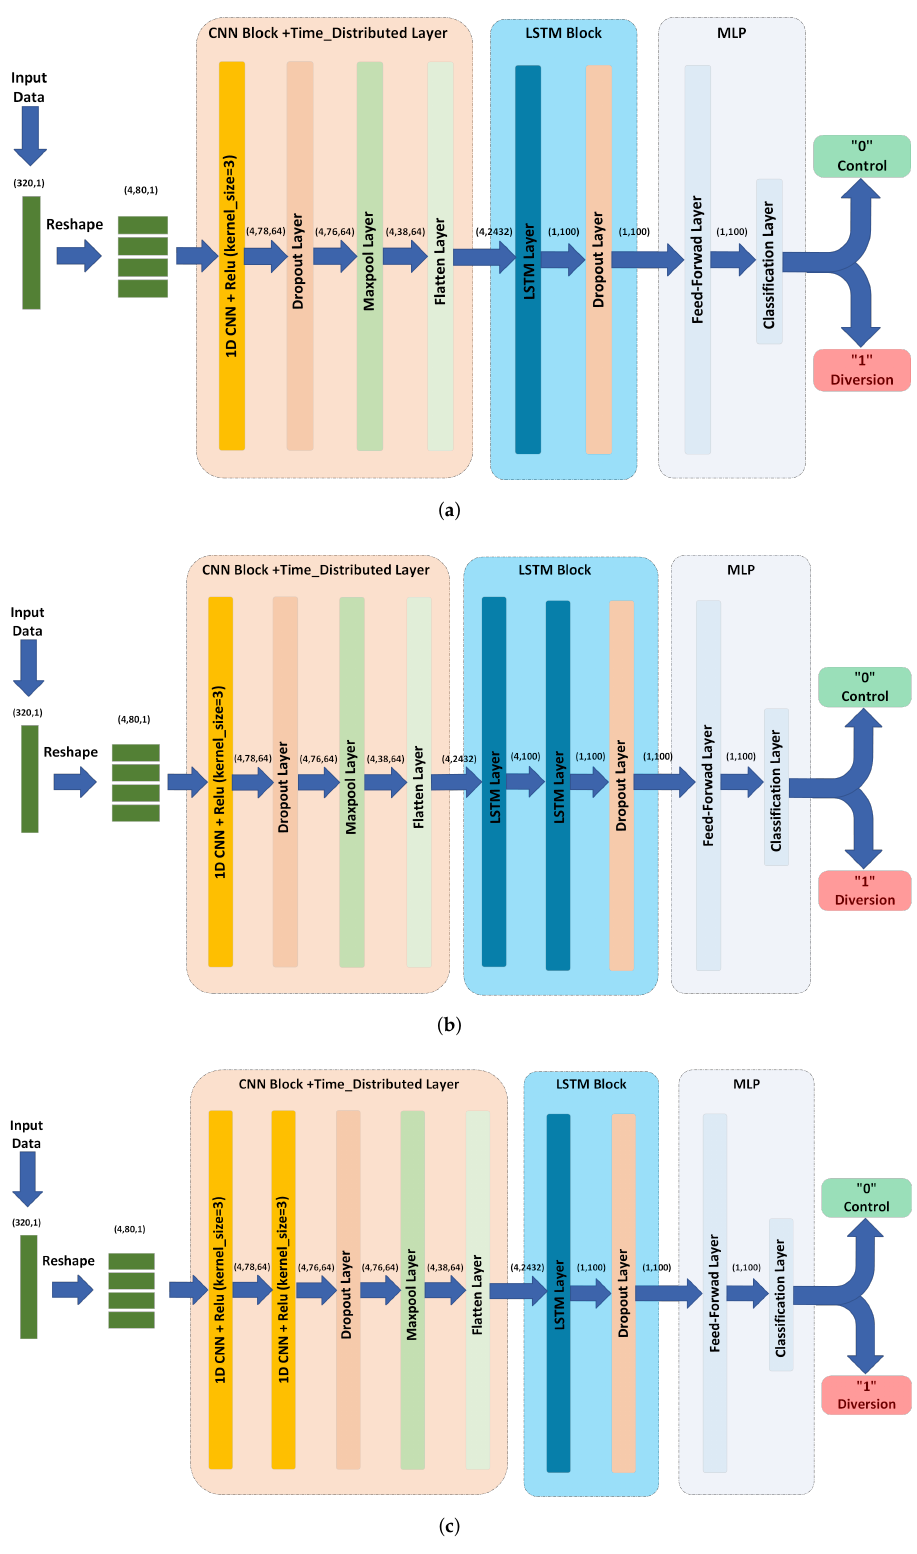
Figure 10. CNN-LSTM based models’ architectures. ( a ) CNN-LSTM model. ( b ) CNN-(2-LSTM) model. ( c ) (2-CNN)-LSTM